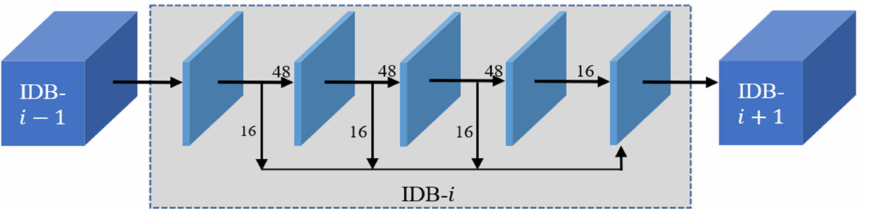
Figure 3. Information distillation module.